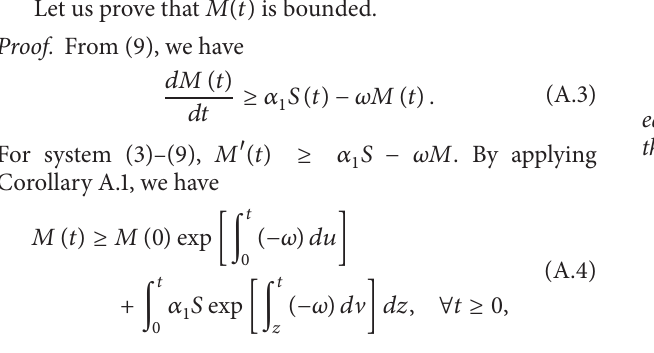
Figure 6: Reproduction number contour